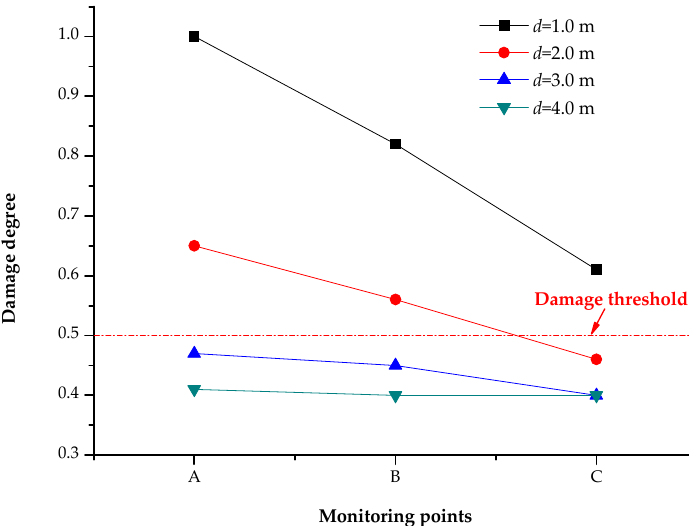
Figure 14. Rock damage degree variation of different monitoring points with d .